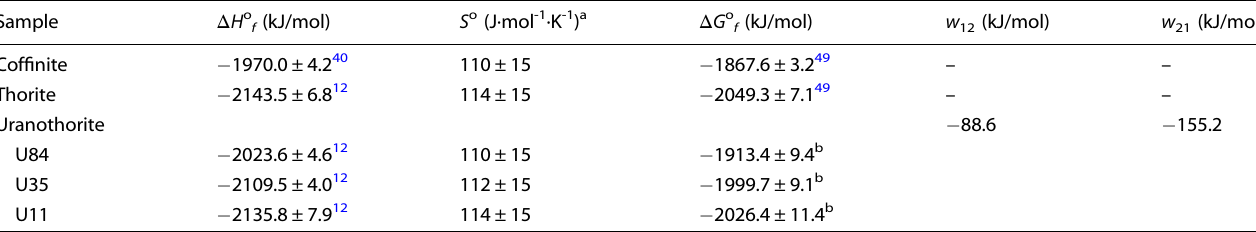
Table 3. Selected thermodynamic parameters at the standard condition and 25 °C, used in the multi-component system thermodynamic